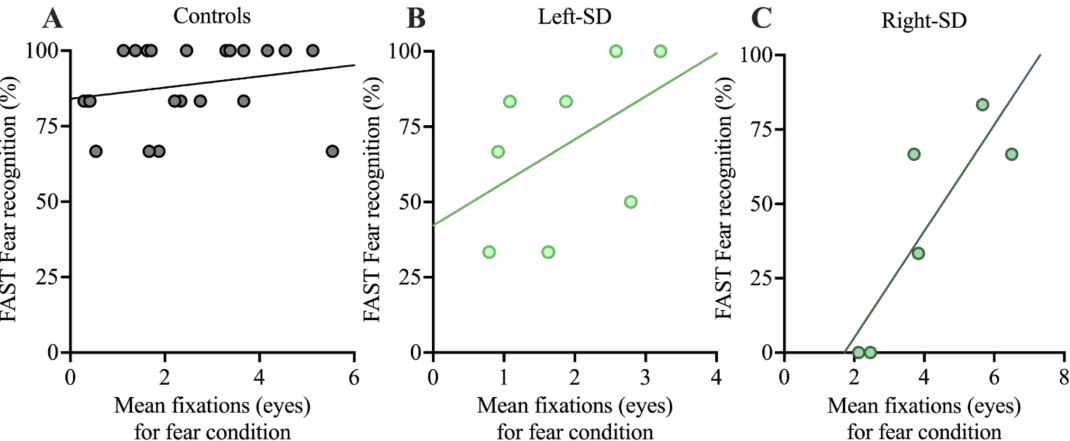
Figure 4. Correlations between performance on the FAST for fear recognition and mean number of fixations to the eyes in the fearful condition in A: controls, B : left-SD, and C : right-SD. FAST: Facial Affect Selection Task.